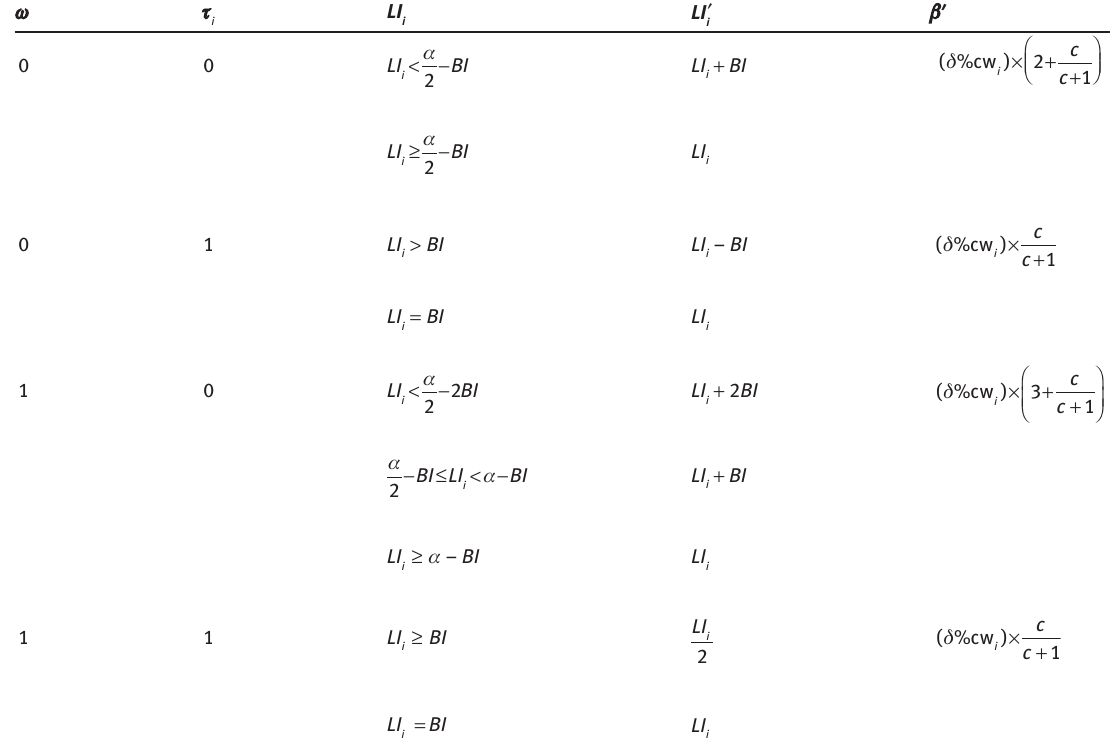
Table 1. Parameter Updates in the Energy-Efficient Strategies of the APSM